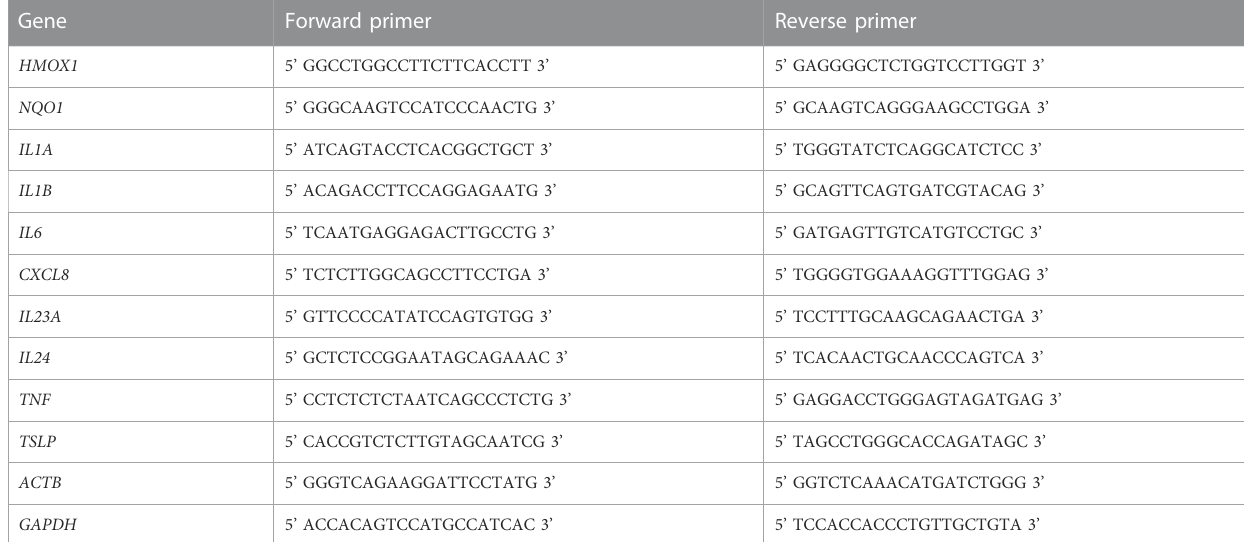
TABLE 1 Sequences for primers used in